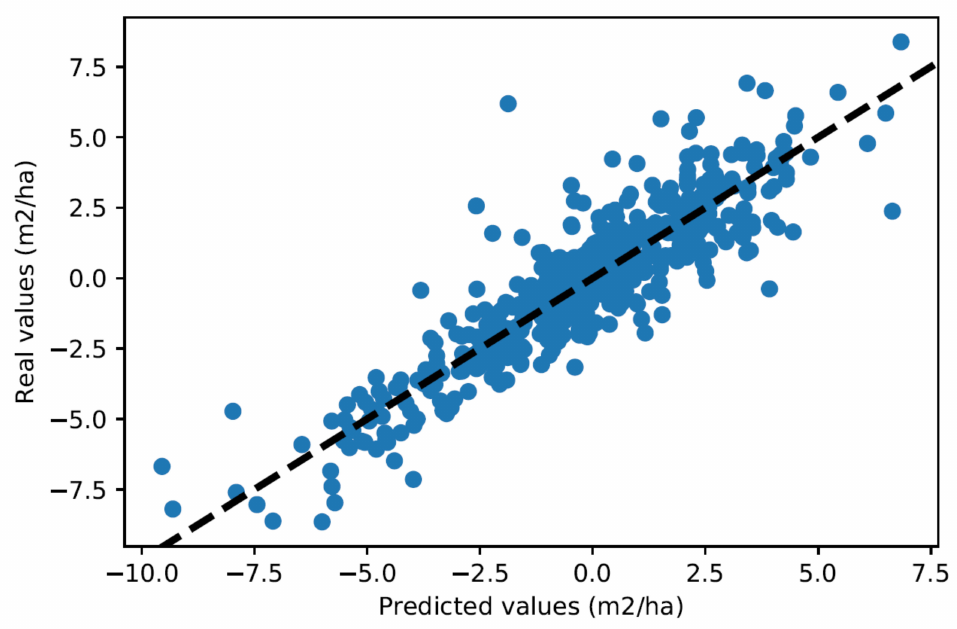
Figure 15. Residuals plot for ∆ G predictions at the level of couples (division, inventory year) for the medium woods